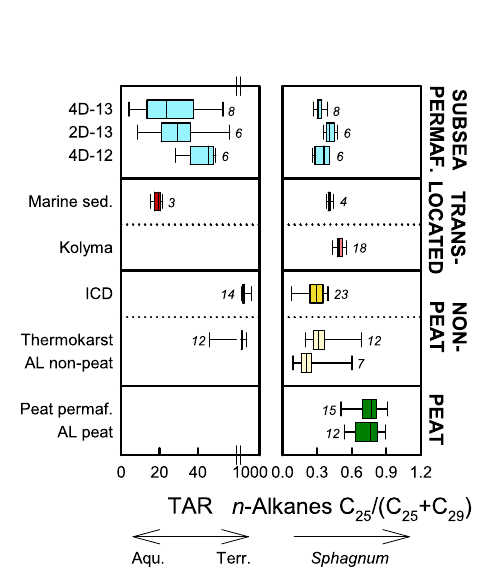
Fig.4|Comparisonof n -alkanesourceproxiesinsubseapermafrostwithother deposits in Siberia. Subsea permafrost data represent the thaw front of cores 4D-13, 2D-13, and 4D-12 from the Buor-Khaya Bay. Shown are terrigenous- aquatic ratios (TAR) re fl ecting the contribution of aquatic (aqu.) and land- derived (terr.) material, and C 25 /(C 25 +C 29 ) n -alkane ratios re fl ecting Sphagnum contribution. Data from previous studies show terrestrial deposits from peat and non-peat locations including Ice Complex deposits (ICD) 36,44 , Holocene thermokarst 36 , peat permafrost 45 , and active layer (AL) material 44,45 , as well as translocated material including Buor-Khaya Bay surface sediments (sed.) 42,46 and Kolyma river suspended matter 47 . Box plots show medians with 25th and 75th percentiles as box limits, minimum/maximum values as whiskers, and numbers of observations in italics.